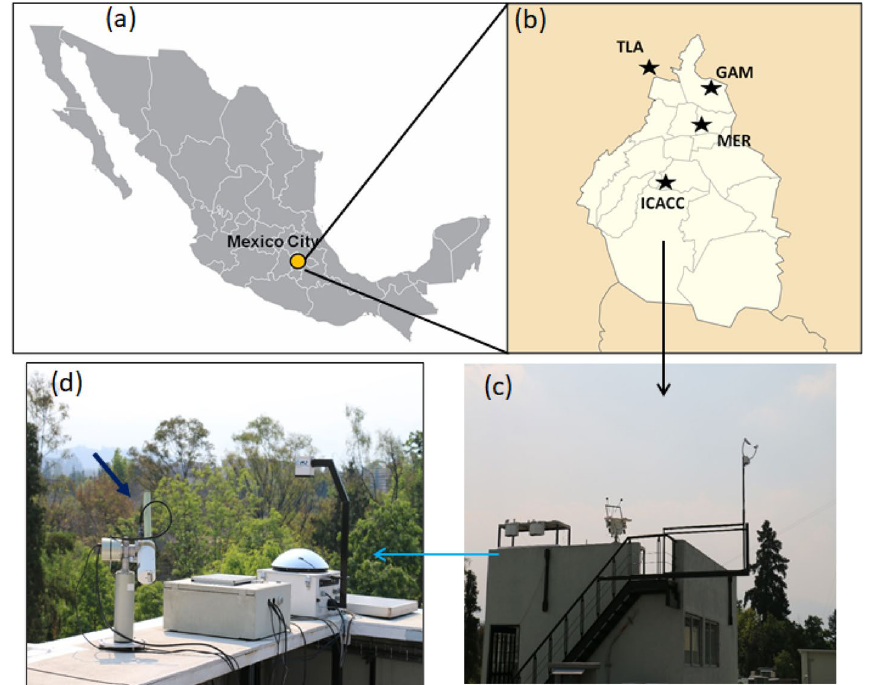
Figure 1. ( a ) Map of Mexico and the geographic location of the MC. ( b ) Map of MC basin and the location of ICACC aerosol observation site. ( c ) AERONET site at the OSR and ( d ) picture of the CIMEL-318 sunphotometer on its measurement